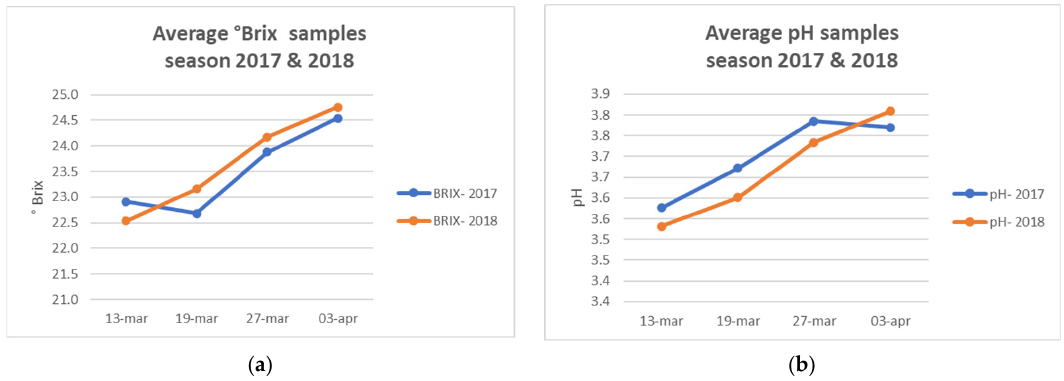
Figure 7. Comparison of average °Brix samples ( a ) and pH samples ( b ) in both seasons. The average of pixels located in a buffer of 15 m around the sampling point was considered to be representative of the variables measured in the field. For each sampling date, a table was created to show, in each plot, the value of the sample corresponding to the average of the berries taken around a radius of 15 m, and the average of pixels obtained from the images as indicated in Table 3. In summary, 14 samples with 12 independent variables per date were used to determine if there was a combination of variables that explained the sugar content and the pH values in the berries. Table 3. Average pixel values in each sample. Acquisition date: 13 March 2017.